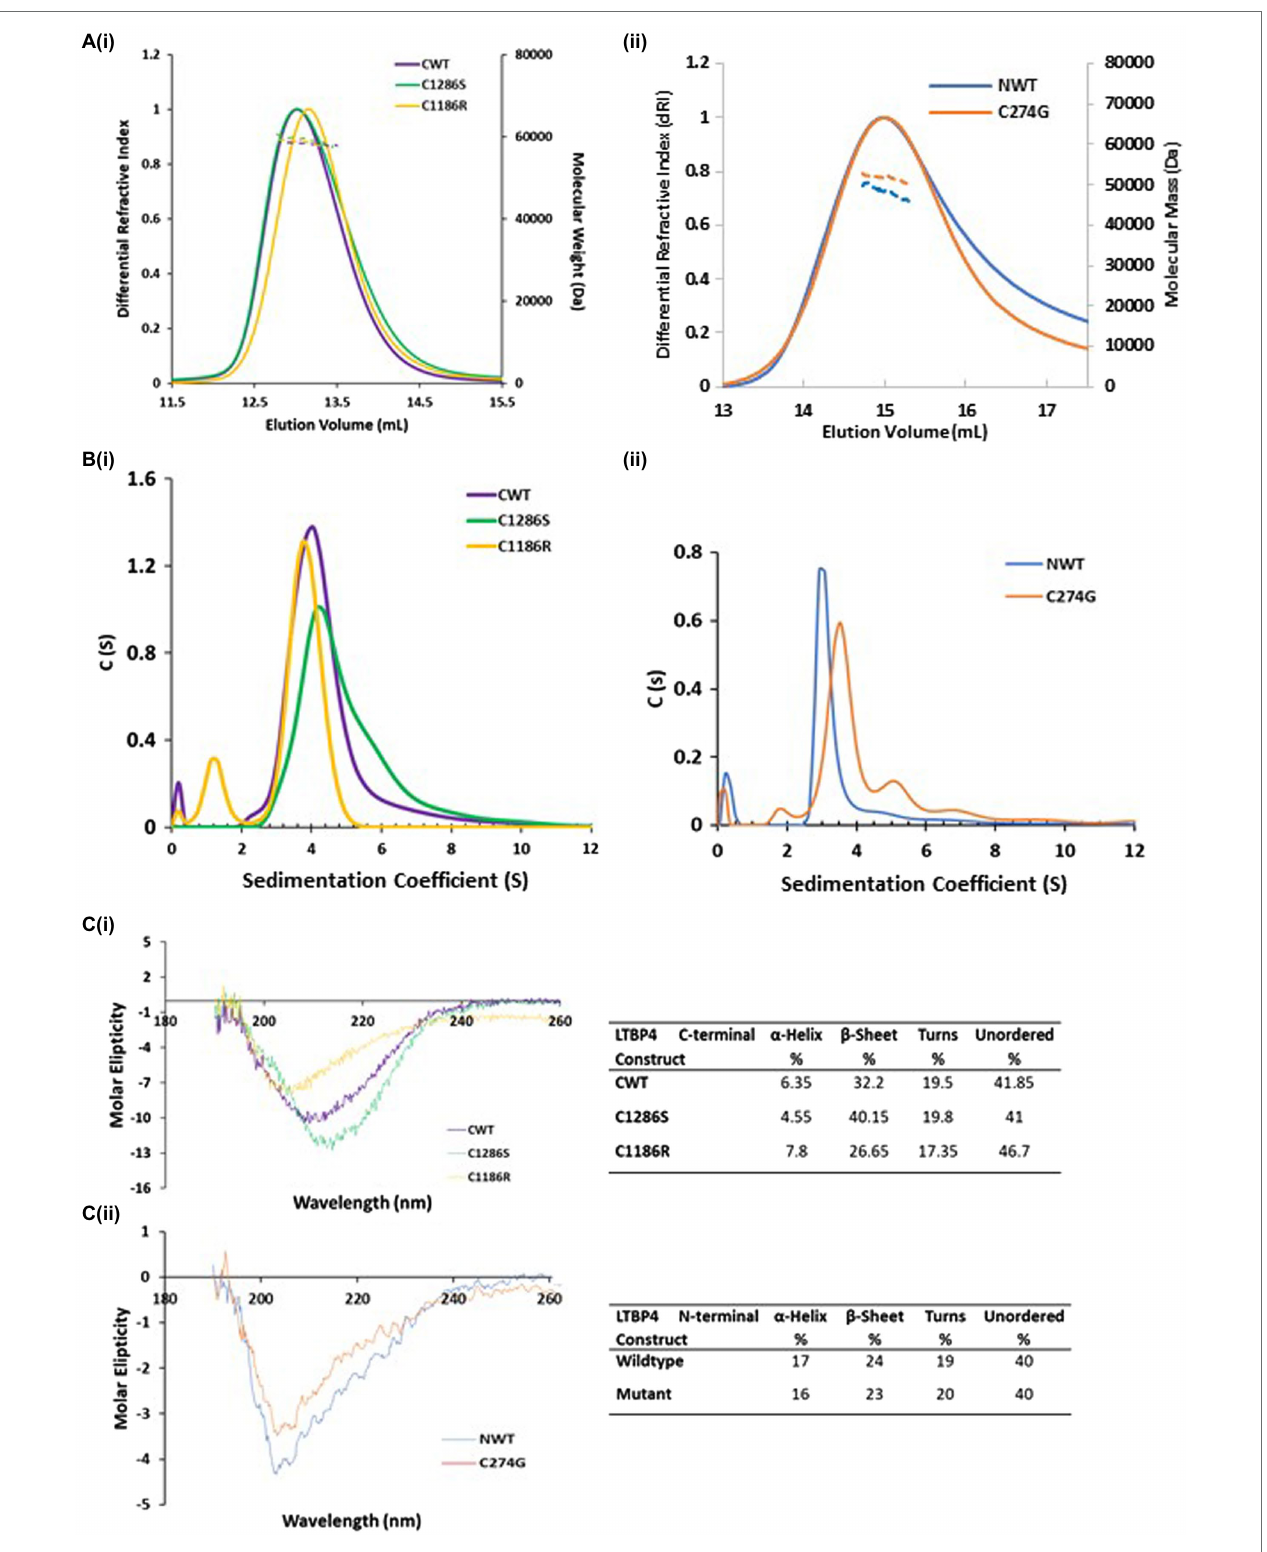
FIGURE 2 | Hydrodynamic properties and secondary structural characterisation of LTBP4. (A) SEC-MALS chromatograms in which the differential refractive index (solid lines) and molecular weight (dashed lines) are plotted as a function of elution volume (ml). The colours are purple (CWT), gold (C1186R), green (C1286S),